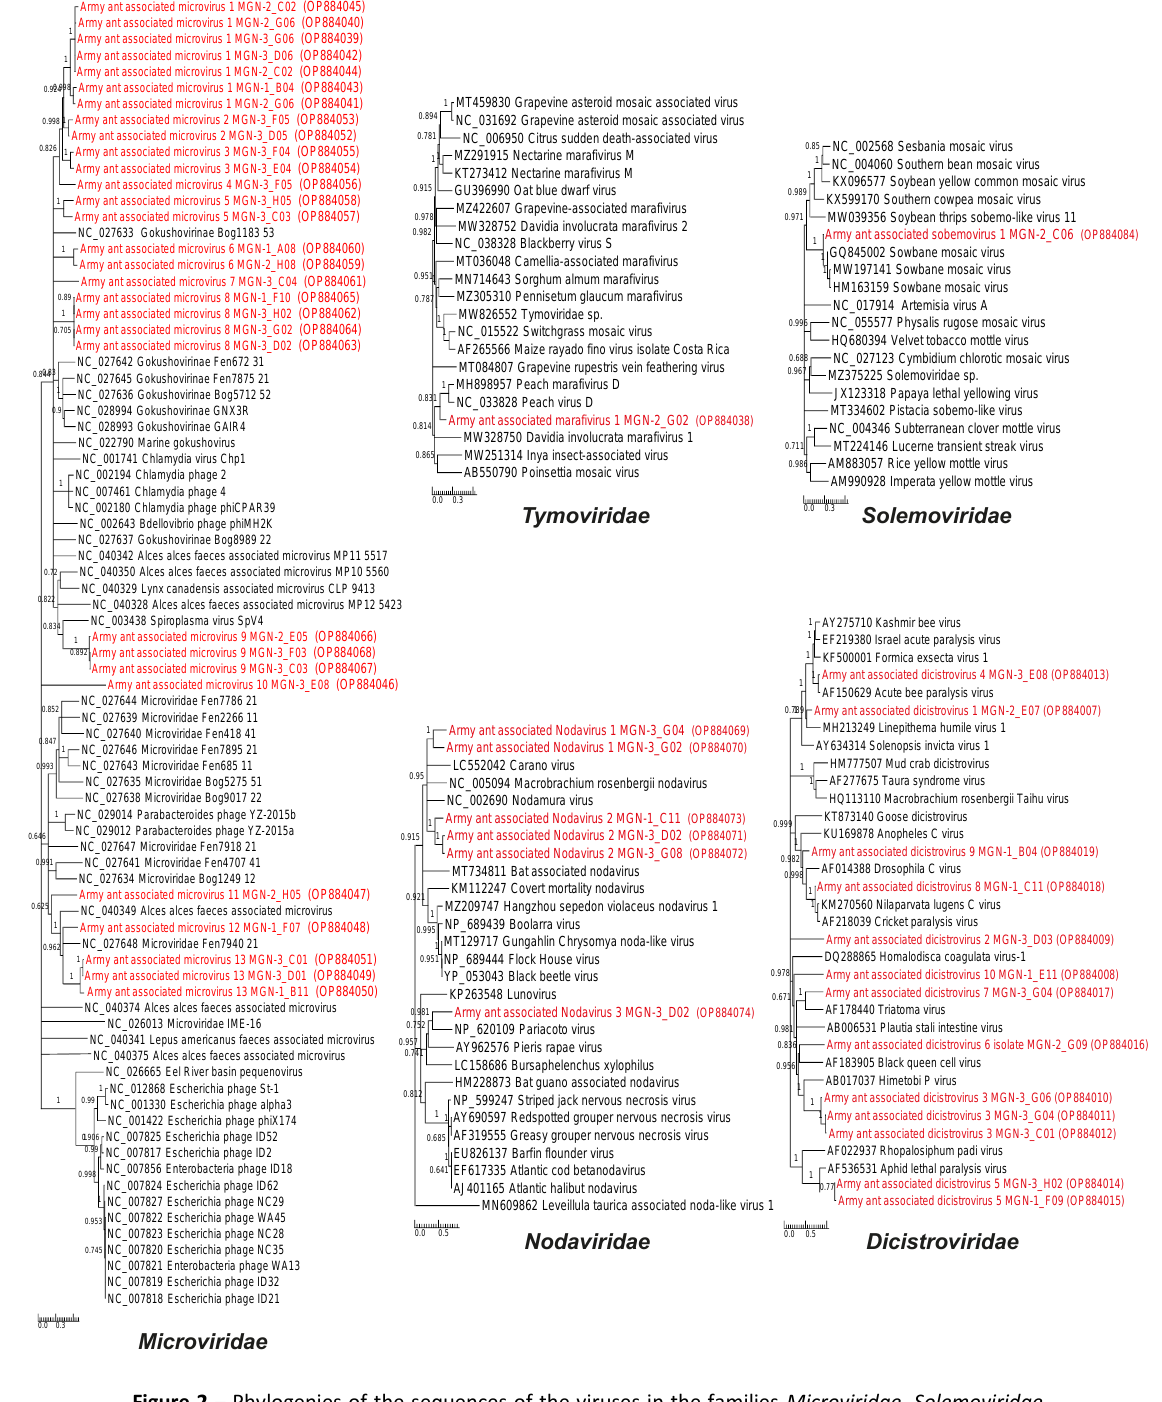
Figure 2 – Phylogenies of the sequences of the viruses in the families Microviridae , Solemoviridae , Tymoviridae , Nodaviridae and Dicistroviridae . Sequences in red refer to army ant-associated contigs. Neighbor joining phylogenetic trees were generated using alignments of Microviridae major capsid protein sequences ranging from 306 aa to 761 aa, Dicistroviridae RNA-dependent RNA polymerase protein sequences (694-2775 aa), Nodaviridae RNA-dependent RNA polymerase protein sequences (656-1033 aa), Solemoviridae RNA-dependent RNA polymerase protein sequences (262 aa) and Tymoviridae polyprotein protein sequences (117 aa). One thousand bootstrap replicates were performed to quantify branch support. The scale bar depicts the number of amino acid substitutions per